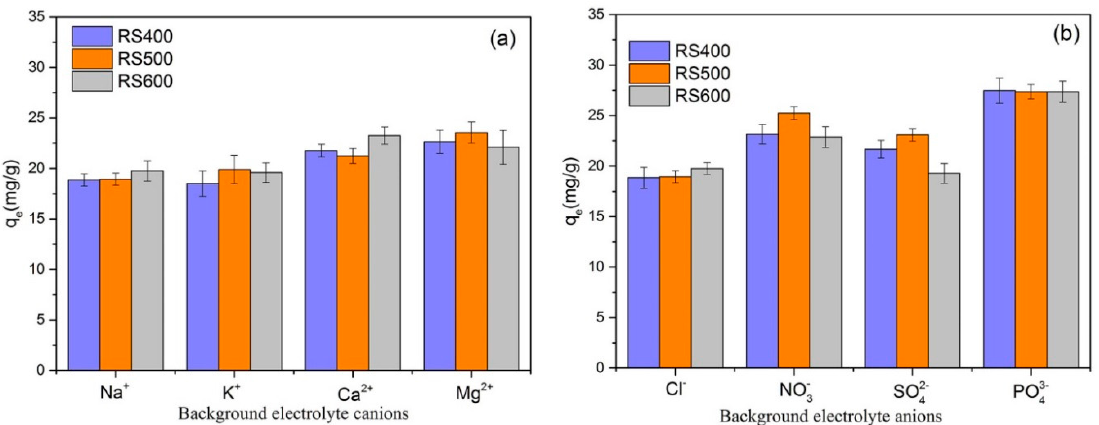
Figure 6. ( a ) Effect of background electrolyte cations on E2; ( b ) Effect of background electrolyte anions on E2 (initial concentration = 6 mg L − 1 ; biochar dose = 0.01 g; temperature = 301 K).